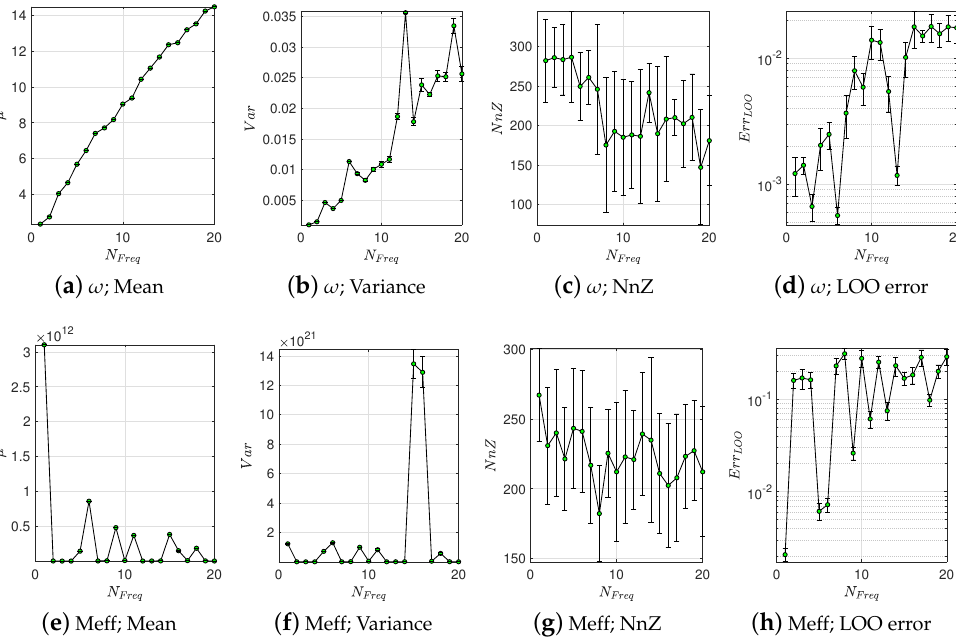
Figure 5. Dam-1; Probabilistic PCE-based surrogate models for different vibration frequencies and quantity of interests (QoIs) all with 800 DOE; ω : frequency.